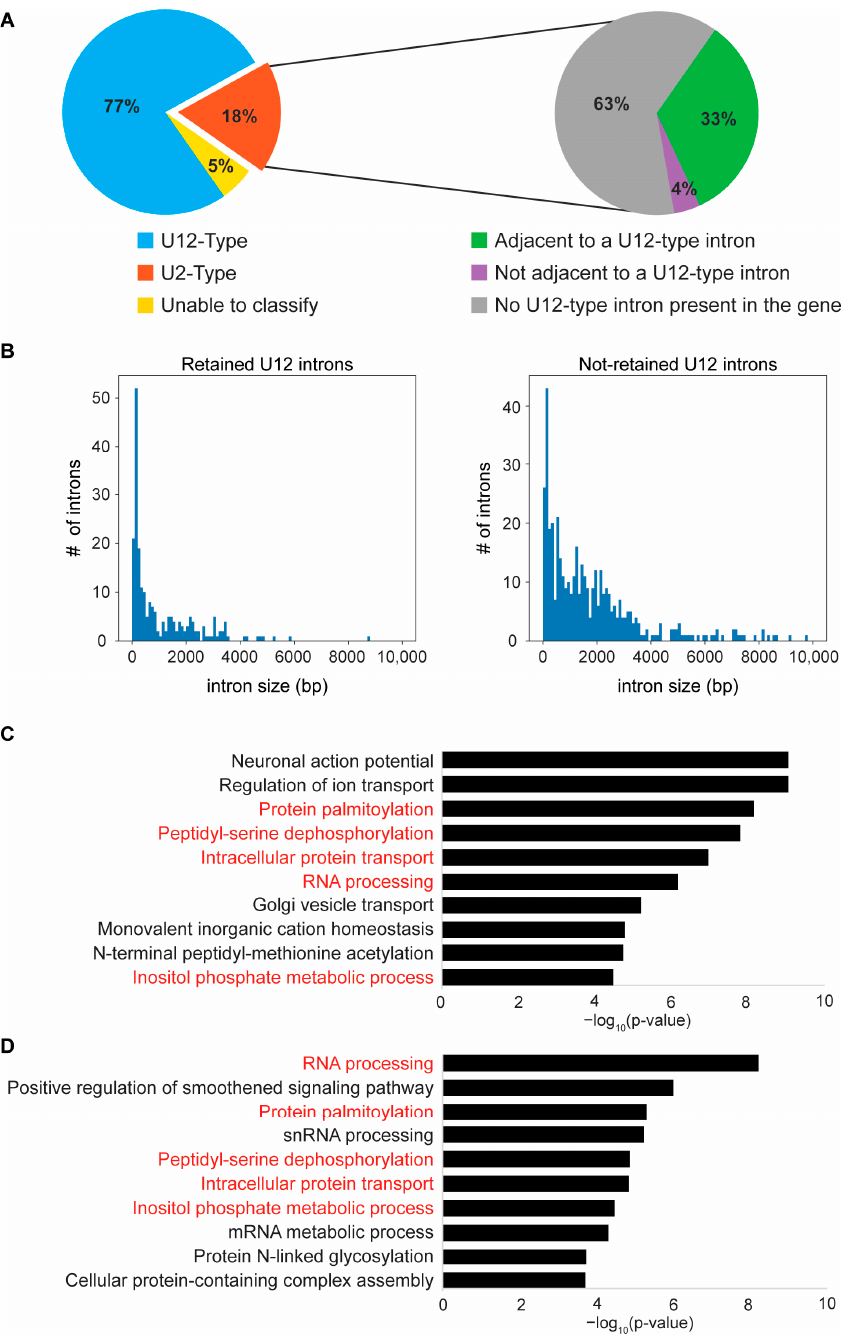
Figure 5. Loss of zrsr2 leads to the differential retention of U12-type introns in RNA and protein processing genes. ( A ) Pie charts depicting the classifications for all differentially retained introns between zrsr2 hg129/hg129 and WT embryos into U12-type (blue) and U2-type (orange) introns (left) and the further classification of the retained U2-type introns (right) by whether they are adjacent to a known U12-type intron (green) or not adjacent but in a gene with a U12-type intron (purple), or in a gene with no known U12-type introns (grey). Some of the retained introns could not be classified into either category (yellow). ( B ) Plots of intron size distribution in the retained U12-type introns (left) and the non-retained U12-type introns (right). ( C ) The top 10 biological processes enriched in all genes (612) containing U12-type introns in the zebrafish genome according to IAOD. ( D ) The top 10 biological processes enriched in the set of U12-type intron containing genes (221) that have a differential IR between WT and zrsr2 hg129/hg129 embryos at 3 dpf, with enrichment visualized by − log10 ( p -value). Five of the ten top pathways (written in red) are common in both gene sets ( C , D ).